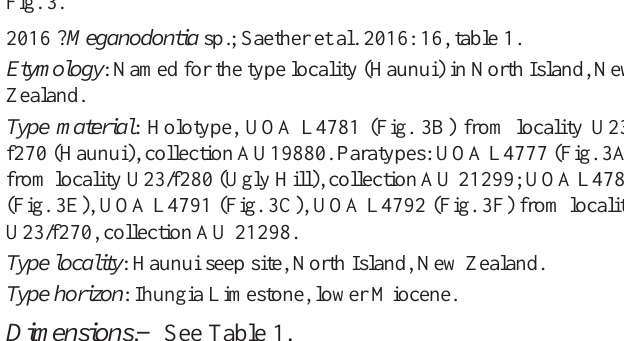
2016 ? Meganodontia sp.; Saether et al. 2016: 16, table 1. Etymology : Named for the type locality (Haunui) in North Island, New Zealand. Type material : Holotype, UOA L4781 (Fig. 3B) from locality U23/ f270 (Haunui), collection AU19880. Paratypes: UOA L4777 (Fig. 3A) from locality U23/f280 (Ugly Hill), collection AU 21299; UOA L4782 (Fig. 3E), UOA L4791 (Fig. 3C), UOA L4792 (Fig. 3F) from locality U23/f270, collection AU 21298.